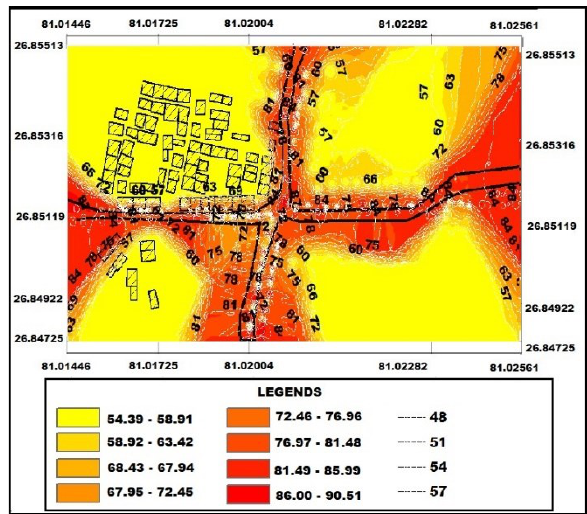
Figure 8. Noise level map of Haniman crossing for organized road for evening